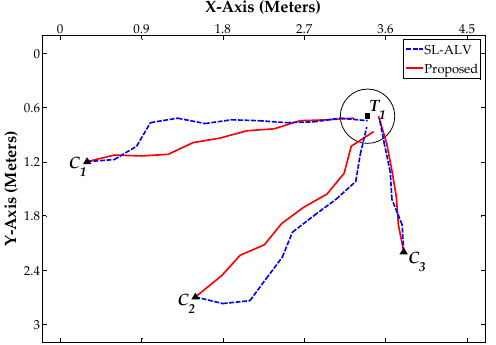
Figure 14. Homing Experiment 1. The target area is denoted as a circle centered on a square block. The three starting location C 1 , C 2 and C 3 are marked as triangular blocks. Blue dashed lines denote the homing trajectories generated by SL-ALV. Red solid lines denote the homing trajectories generated by our proposed strategies. Table 4. Associated results of homing experiment 1.